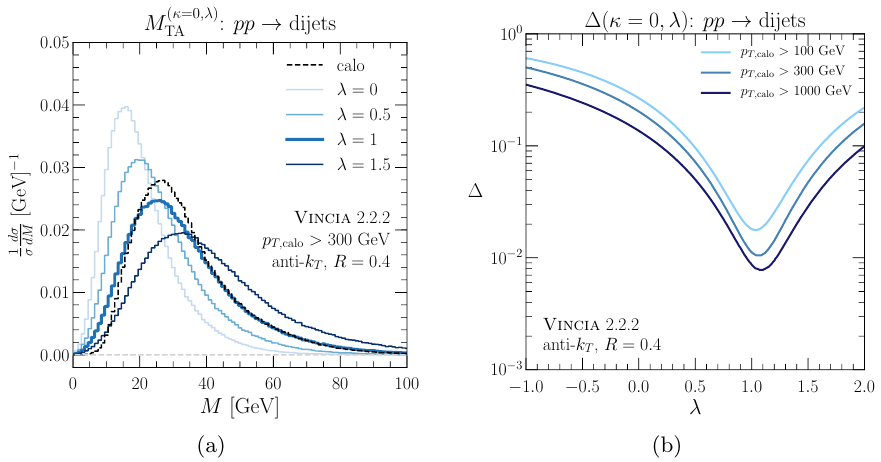
Figure 2 . (a) GTAM distributions for p T; calo > 300 GeV with (cid:20) = 0 and (cid:21) = ordinary jet mass plotted as a dashed black curve for comparison. (b) (cid:1)(0 ; (cid:21) ) as a function of (cid:21) , in the p T; calo > 100 GeV, p T; calo > 300 GeV, and p T; calo > 1000 GeV